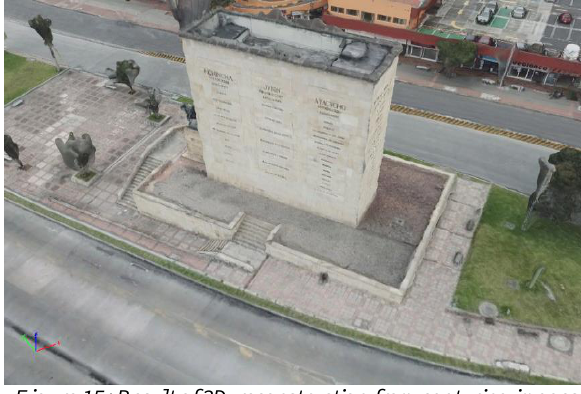
Figure 15: Result of 3D reconstruction from capturing images from a top side view drone flight.